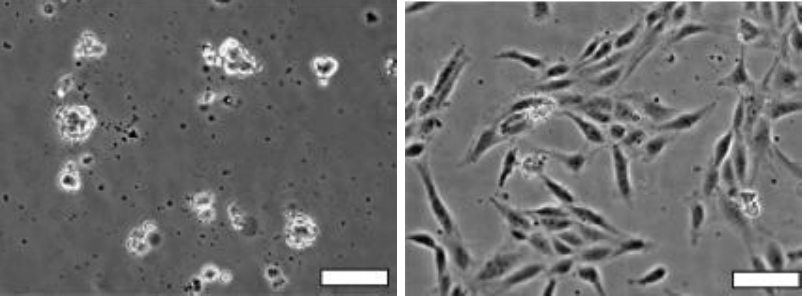
Figure 9. Human umbilical endothelial cells cultured on bare PEG gel (left) and PEG/RGD gel (right) surfaces [50]. Scale bars are 100 μm. Cells on RGD modified PEG surface showed an elongated morphology, while the cells on the bare PEG surface showed a round